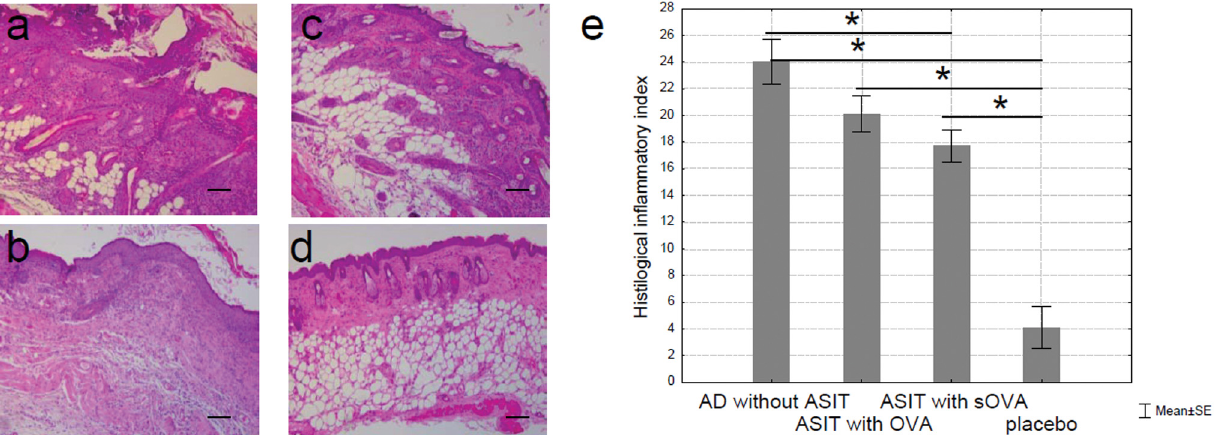
Fig 6. Histologic features of OVA- and sOVA-treated skin sites in BALB/c mice. (a) Mice sensitized with OVA and treated with PBS ( “ AD without ASIT ” ), (b) mice sensitized with OVA and treated with OVA ( “ ASIT with OVA ” ), (c) mice sensitized with OVA and treated with sOVA ( “ ASIT with sOVA ” ), and (d) mice sensitized with PBS ( “ placebo ” ). Skin sections were stained with H&E and examined at 100x. Scale bars 100 μ m. There is marked hyperplasia of the epidermis, a dermal infiltrate (a-c). The cellular infiltrate consists of neutrophils, eosinophils, and lymphocytes. (e) Summary index of the main assessment criteria for histologic skin